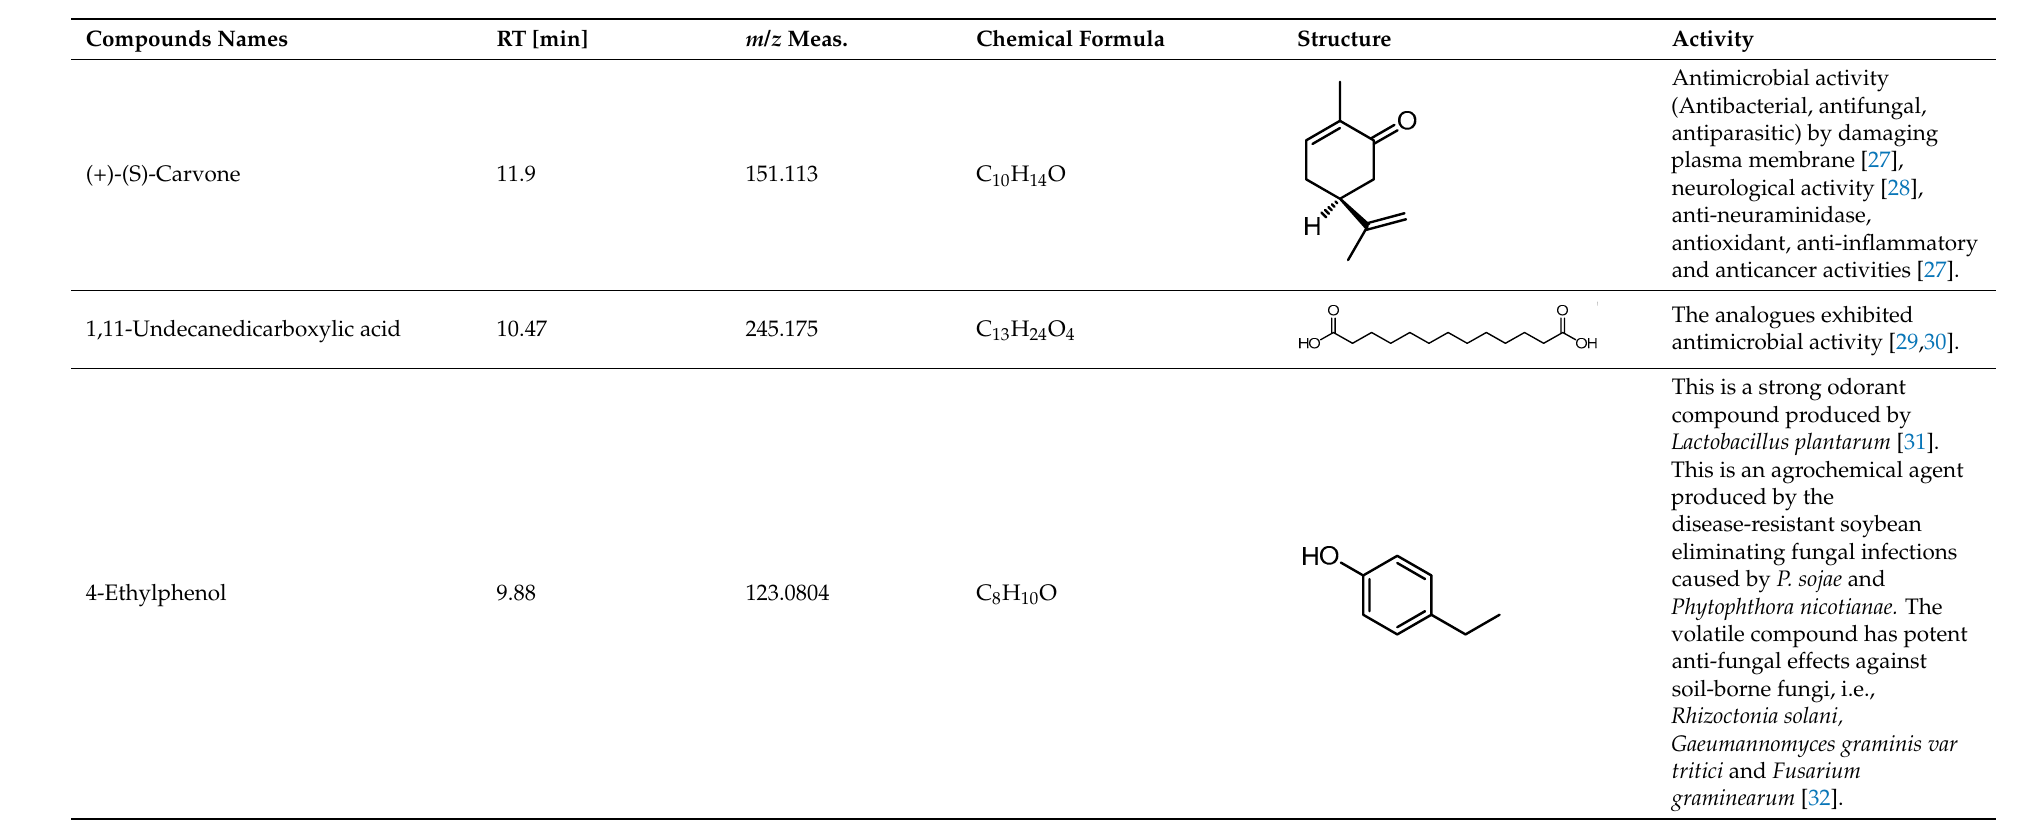
Table 2. Mass spectrometry revealed several compounds with biological activities.